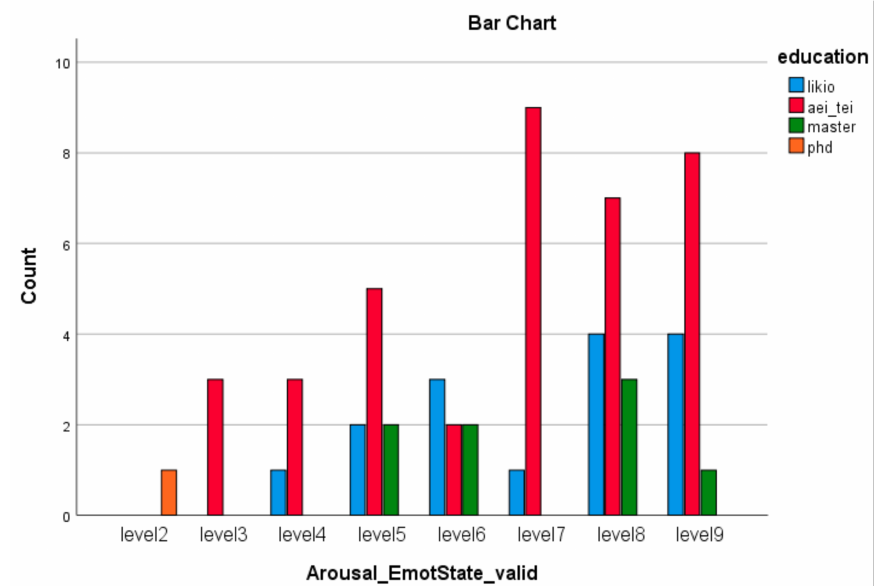
Figure 8. Arousal dimension of emotion scores versus education levels of participants in the groups.